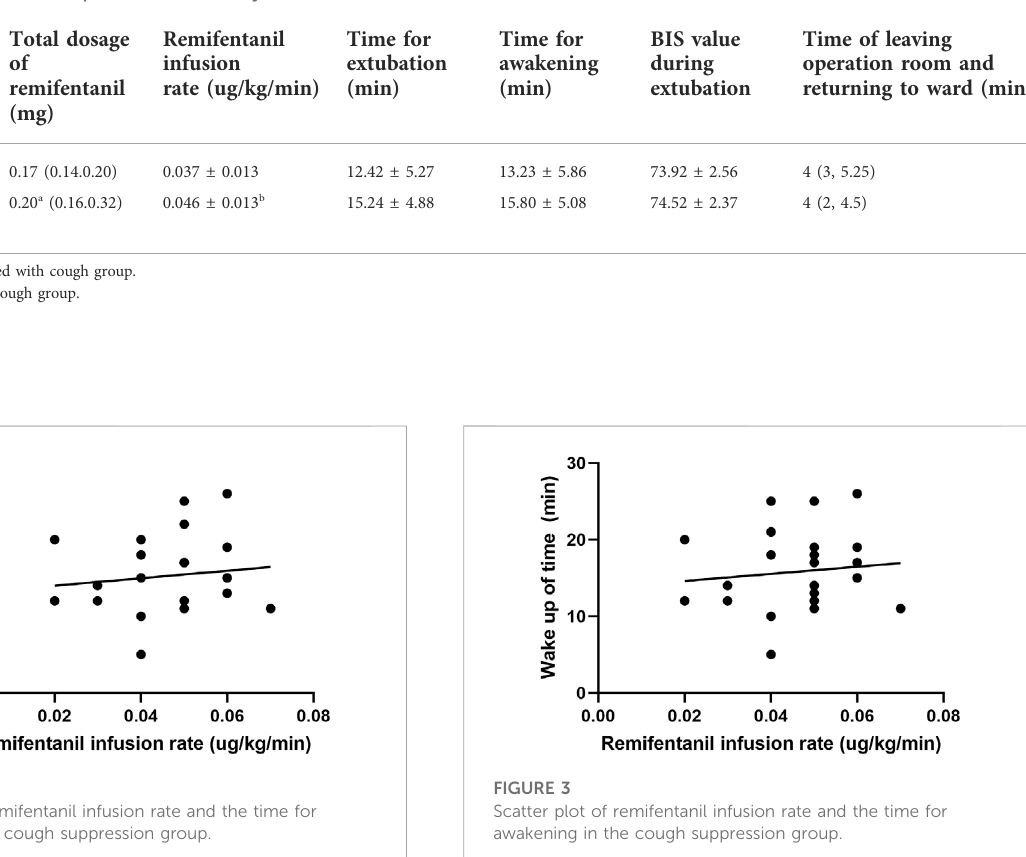
TABLE 2 Comparison of intraoperative and recovery indexes.